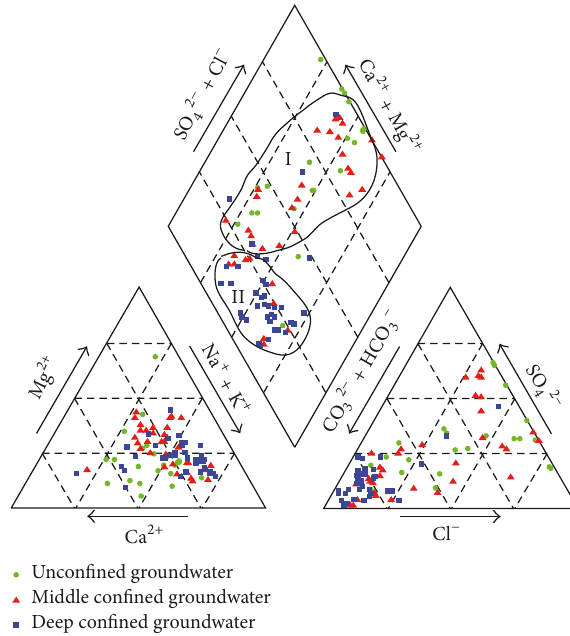
Figure 4: Piper plots of chemical compositions of the coastal groundwater of Zhanjiang.